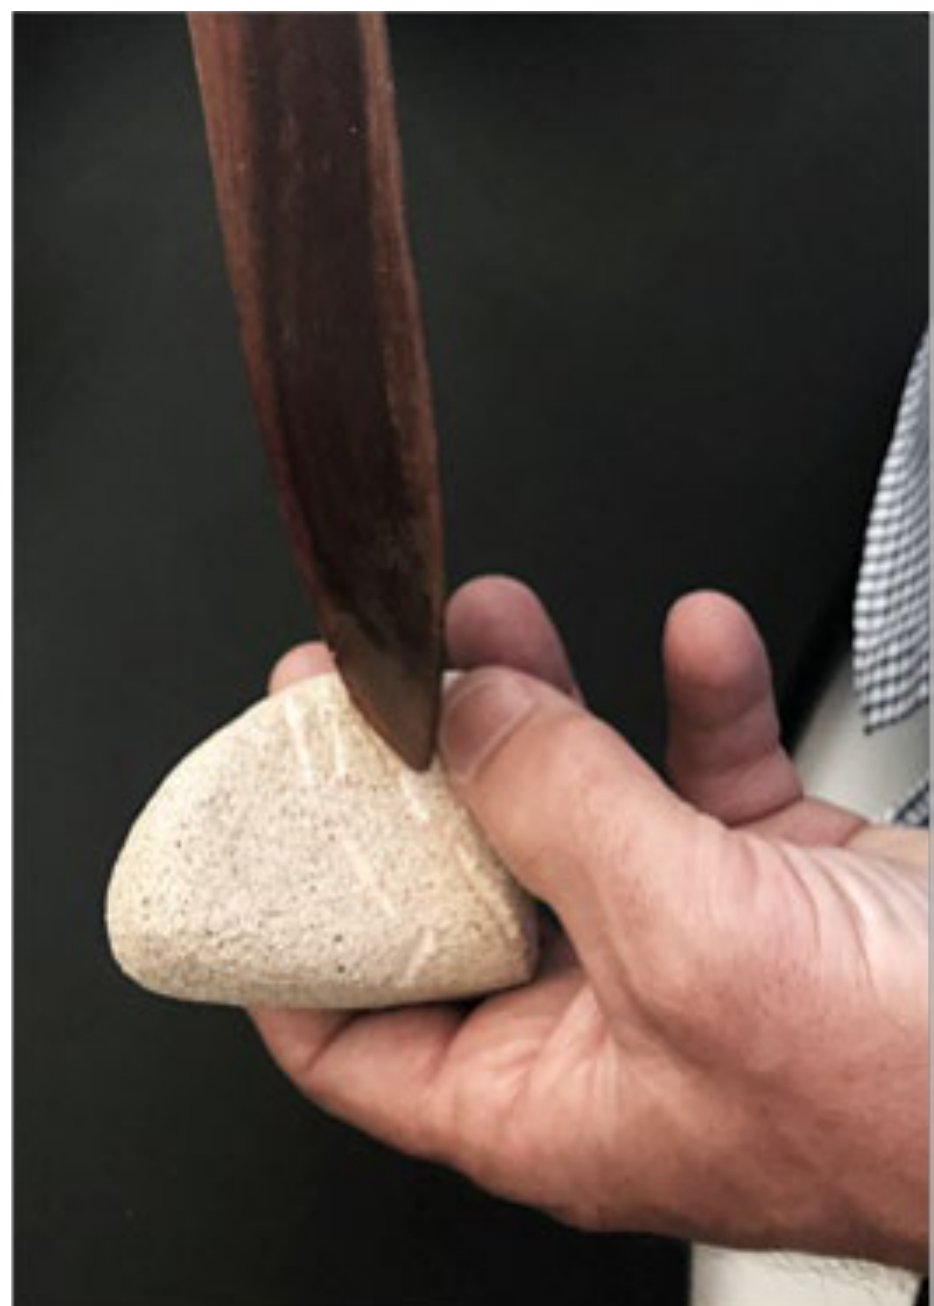
Figure 7. Using the experimental replica tool to sharpen the edge of a